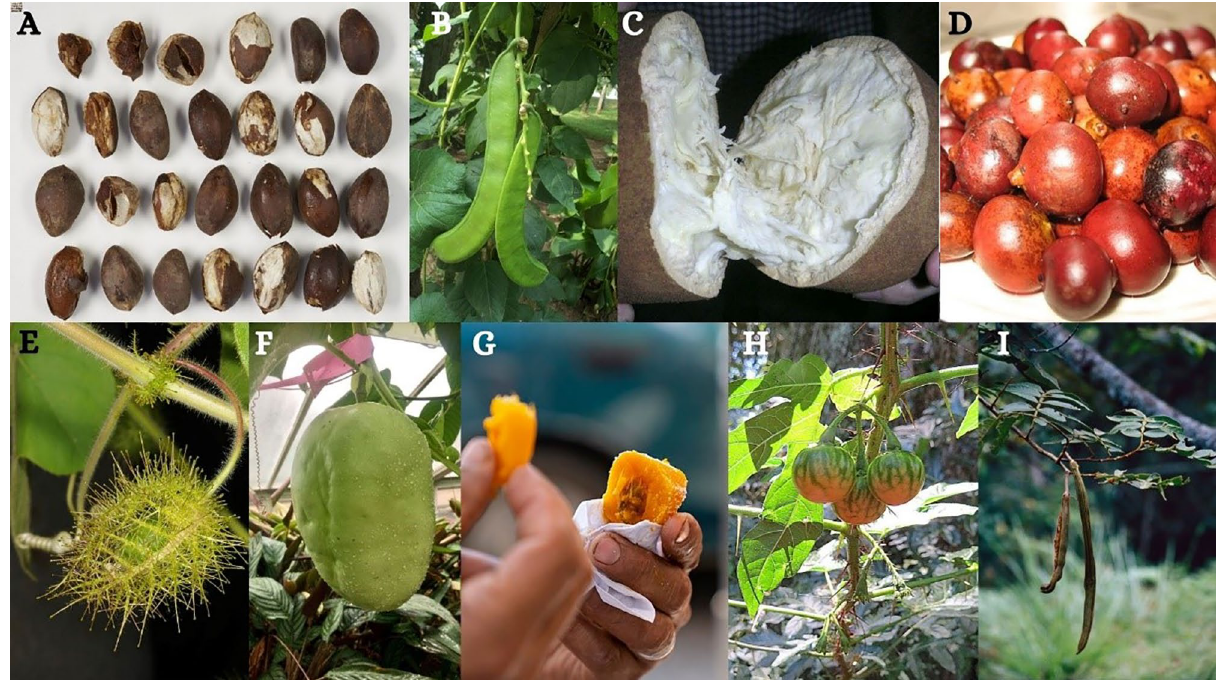
Figure 5. ( A ) Caryodendron orinocense (Photograph by Laura Green, distributed under a CC BY open access license via Colplanta, 2021); ( B ) Canivalia ensiformis (Photograph by Pradeep Rajatewa, distributed under a CC BY open access license via Colplanta, 2021); ( C ) Theobroma grandiflorum (Photograph by BjoernS, distributed under a CC-BY 2.0 license via Wikimedia commons); ( D ) Bactris guineensis (Photograoh by Jdvillalobos, distributed under a CC-BY 2.0 license via Wikimedia commons); ( E ) Passiflora foetida (Photograph by Ori Fragman-Sapir, distributed under a CC BY open access license via Colplanta, 2021); ( F ) Passiflora quadrangularis (Photograph by Rebecca Hilgenhof, distributed under a CC BY open access license via Colplanta, 2021); ( G ) Bactris gasipaes (Photograph by David Yela, distributed under a CC-BY 2.0 license via Wikimedia commons); ( H ) Solanum capsicoides (Photograph by Dick Culbert, distributed under a CC-BY 2.0 license via Wikimedia commons); ( I ) Inga edulis (Photograph by Mauricio Diazgranados, distributed under a CC BY open access license via Colplanta,